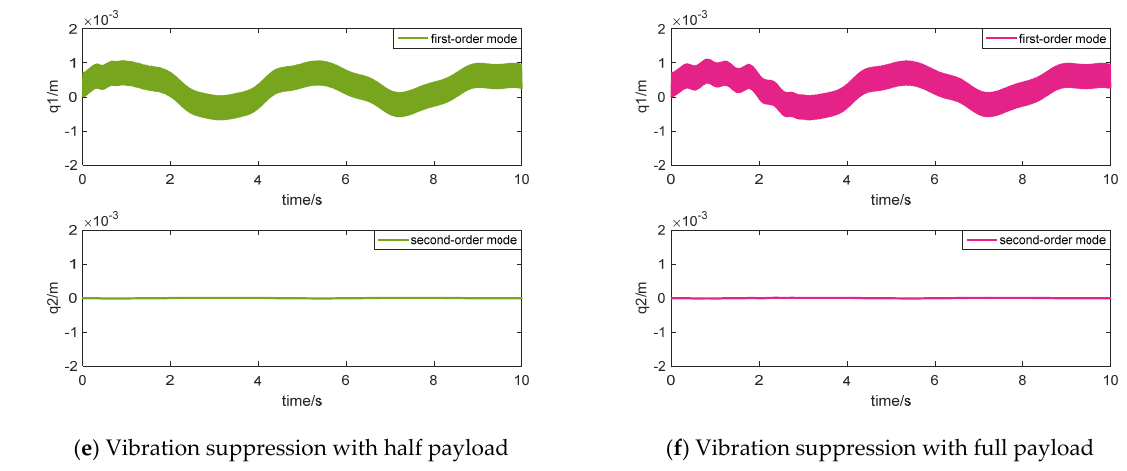
Figure 8. Tracking performances and vibration suppression of the manipulator without uncertainties.